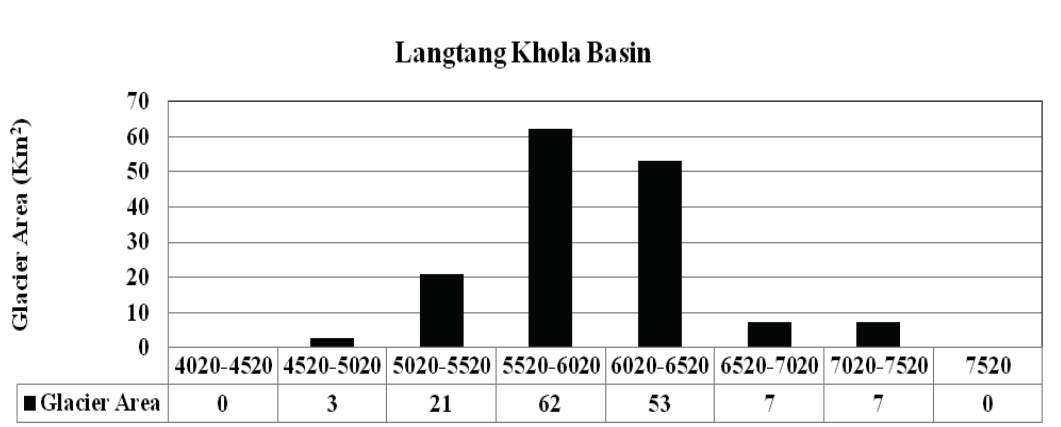
Fig. 2 Glacier Area in elevation